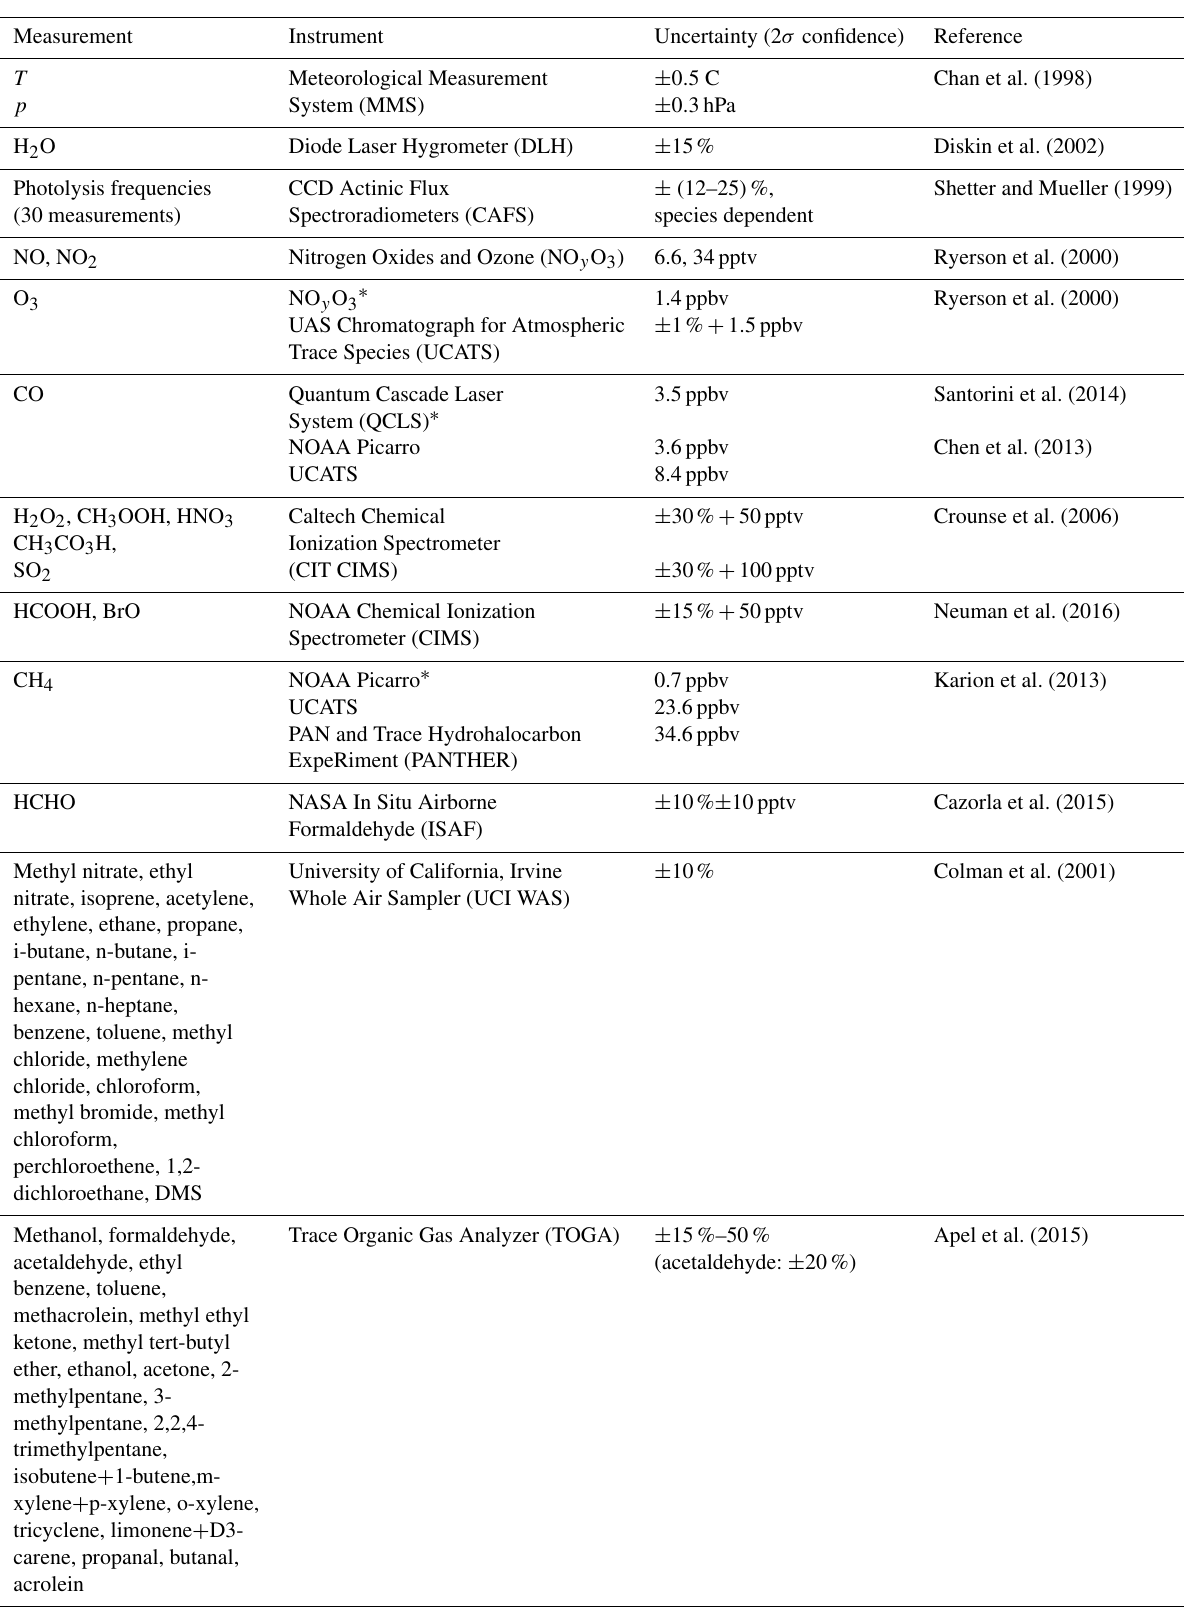
Table 2. Simultaneous measurements used to constrain the box model and calculate OH reactivity.